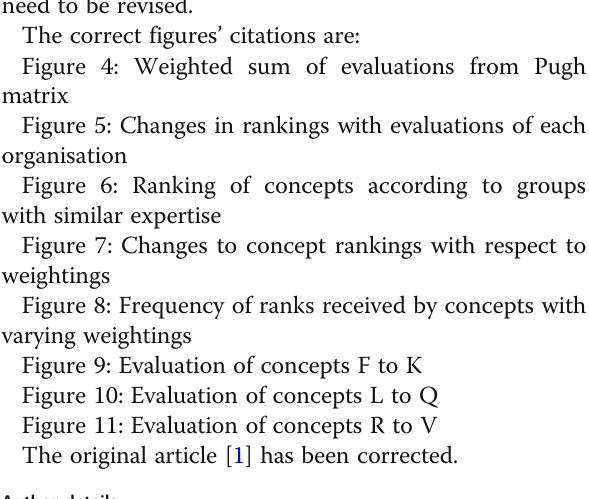
Figure 4: Weighted sum of evaluations from Pugh matrix Figure 5: Changes in rankings with evaluations of each organisation Figure 6: Ranking of concepts according to groups with similar expertise Figure 7: Changes to concept rankings with respect to weightings Figure 8: Frequency of ranks received by concepts with varying weightings Figure 9: Evaluation of concepts F to K Figure 10: Evaluation of concepts L to Q Figure 11: Evaluation of concepts R to V The original article [1] has been